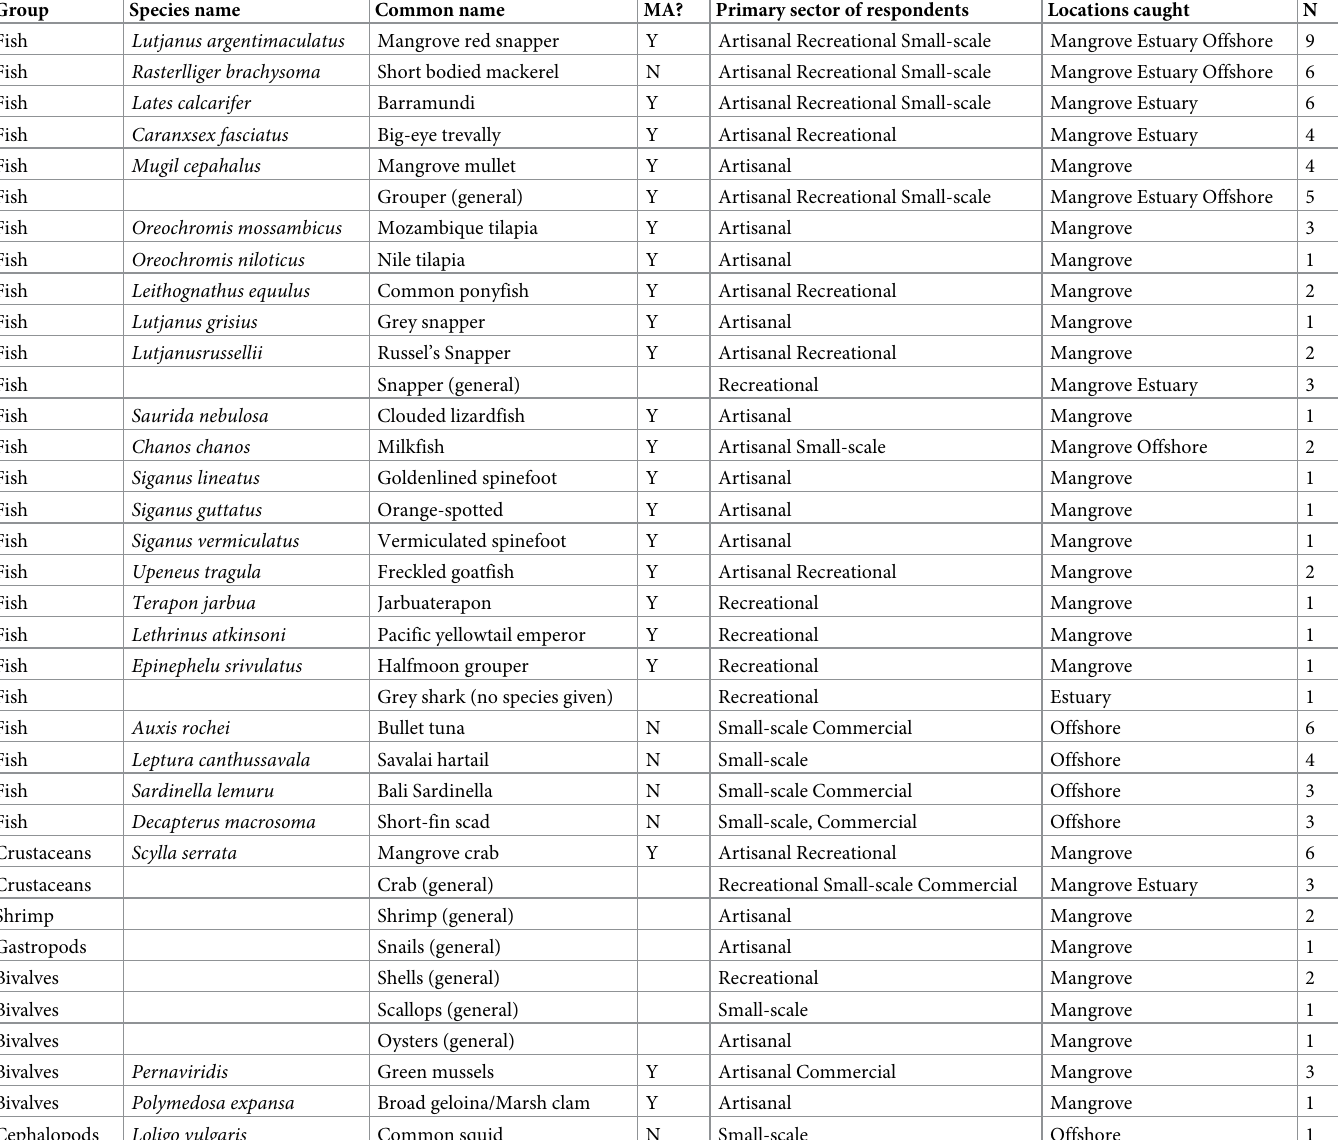
Table 2. Species caught by fishers of all sectors in the Perancak Estuary region of the Jembrana sub-district, Bali, their Mangrove Association (MA), yes (Y) or no (N), along with the fishing sectors of respondents who caught them (by self-identified sector) and the locations in which they have been caught across all sectors.